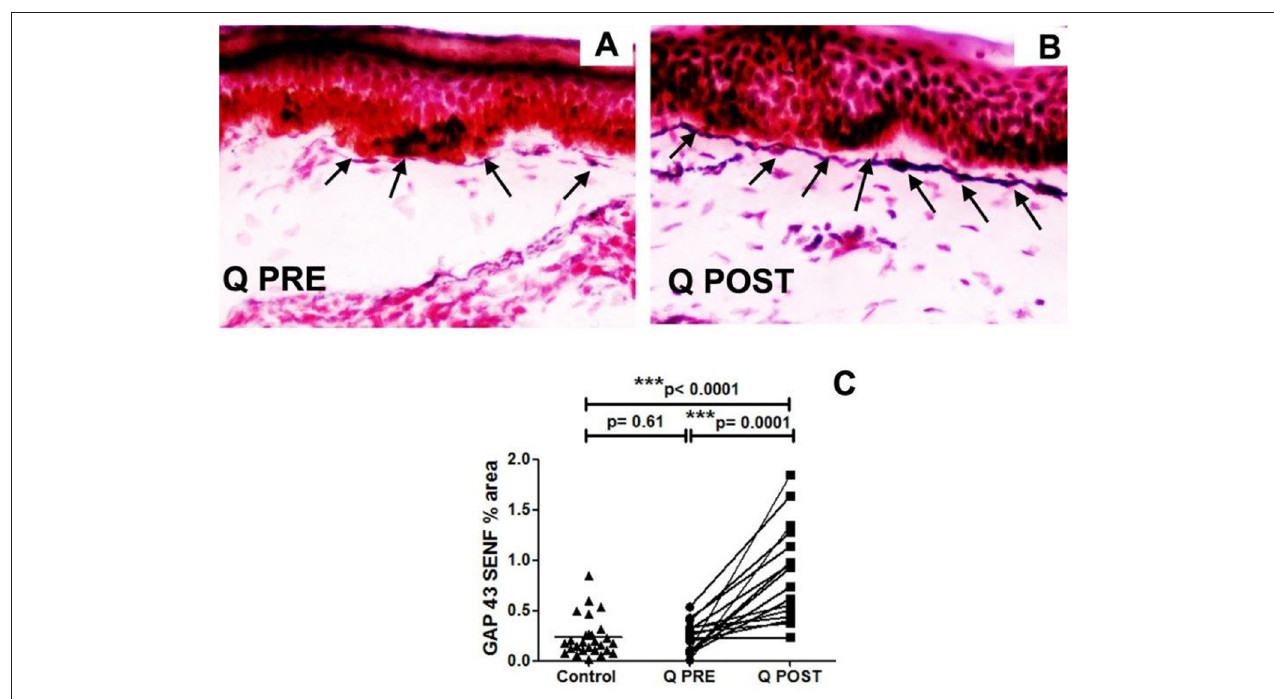
FIGURE 4 | Immunohistochemistry results in skin biopsies for GAP3 nerve fibres. (A) NFCI skin biopsy section before treatment with Capsaicin 8% patch (Q PRE): sub-epidermal nerve fibres (arrows) were present, at a density similar to control/normal skin. (B) NFCI skin biopsy section in the same participant as above, post-treatment (Q POST); skin biopsy collected 3 months after Capsaicin 8% patch Qutenza (Q) application: note the marked increase of GAP 43 positive SENFs in length and thickness. Original magnification × 20. (C) Sub-epidermal GAP43 nerve fibres (SENFs; % Area) at pre-treatment visit (Q PRE) and visit 3 months after treatment (Q POST) with Capsaicin 8% patch Qutenza (Q). Statistically significant increase of SENFs at 3 months after Capsaicin 8% patch application (paired t- test). Statistically non-significant difference between control group and treated group before treatment (Q PRE), but statistically significant difference between control group and treated group after Capsaicin 8% patch application (Q POST) (Mann-Whitney test).